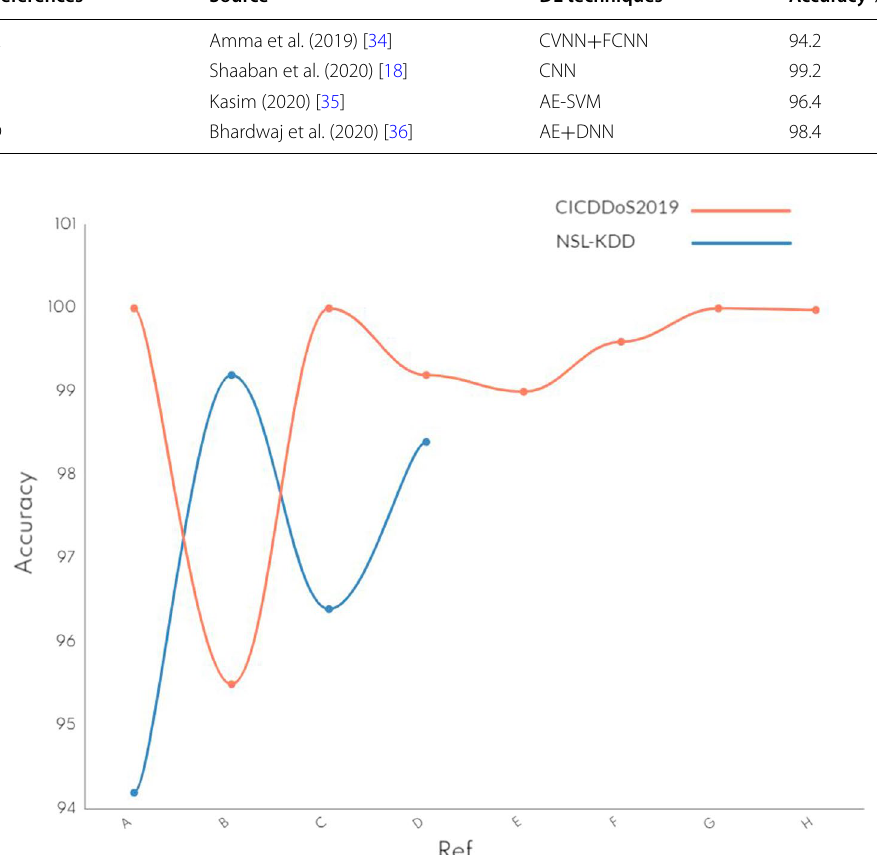
Fig. 2 Accuracy of deep learning approaches for DoS and DDoS attacks detection on CICDDoS2019 Dataset and NSL-KDD